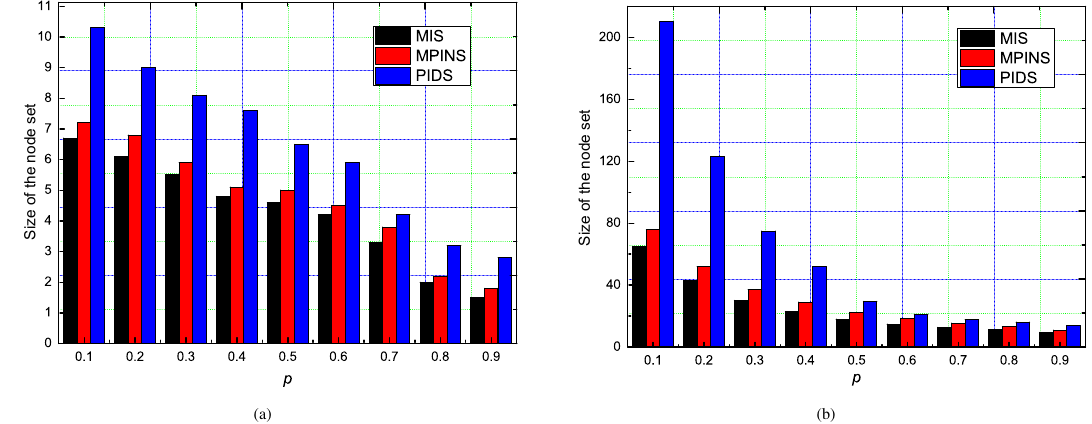
Fig. 7 Size of the node set: (a) n =20 and (cid:18)(cid:18)(cid:18) = 0.5; (b) n = 500 and (cid:18)(cid:18)(cid:18) = 0.5.